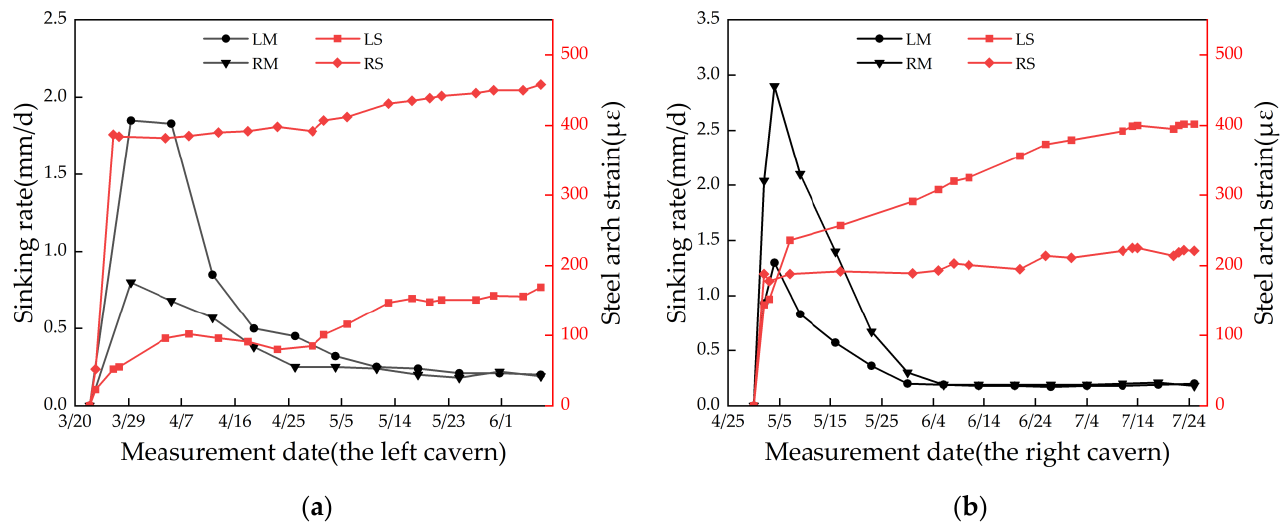
Figure 8. Correlation analysis between the strain and the sinking rate of the primary lining. ( a ) Left cavern; ( b ) right cavern. cavern; ( b ) right